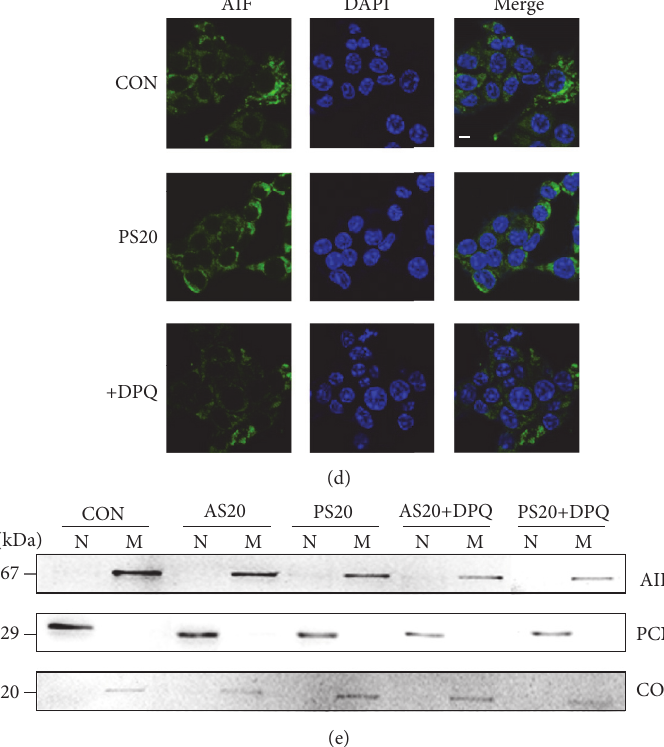
Figure 3: AS- and PS-mediated cell deaths are through necrosis, not apoptosis and parthanatos. (a) NIT-1 cells in AS (20 𝜇 M) for 48 h exhibited decreased cell numbers. When pretreated with NSA or NEC-1, or DPQ, the cells exhibited an increased cell viability; the inhibitor zVAD did not change the percentage of NIT-1 cells. When pretreated with DPQ, the cells exhibited an increased cell viability in 20 𝜇 M PS treatmentbutremainedunchangedafterNSA,NEC-1,andzVADpretreatment.(b)TheRIP1-RIP3-MLKLinteractionwasenhancedfollowing necrosis induction. Whole-cell extracts were used for anti-RIP3 immunoprecipitation. The immune complexes were analyzed using Western blot analysis with the indicated antibodies. Whole-cell lysates (30 𝜇 g, input) were analyzed by Western blotting for RIP3, RIP1, or MLKL. GAPDH is shown as the loading control. (c, d) Representative confocal images of AIF immunoreactivity (green) and nuclear DAPI staining (dark blue). AS and PS treatment did not induce AIF translocation to nucleus. Magnification: × 60. Scale bar: 20 𝜇 M. 300 𝜇 M H 2 O 2 is included as positive control. (e) AIF is still normally localized to the mitochondrial (M) fraction in response to AS and PS treatment, not into nuclear (N) fraction. Proliferating cell nuclear antigen (PCNA) and cytochrome c oxidase subunit IV isoform 1 (COX4) were used as nuclear and mitochondrial marker proteins, respectively. ∗ 𝑃 < 0.05 , compared to the untreated group; † 𝑃 < 0.05 , compared to the only AS- or PS-treated group; mean ± SD from three